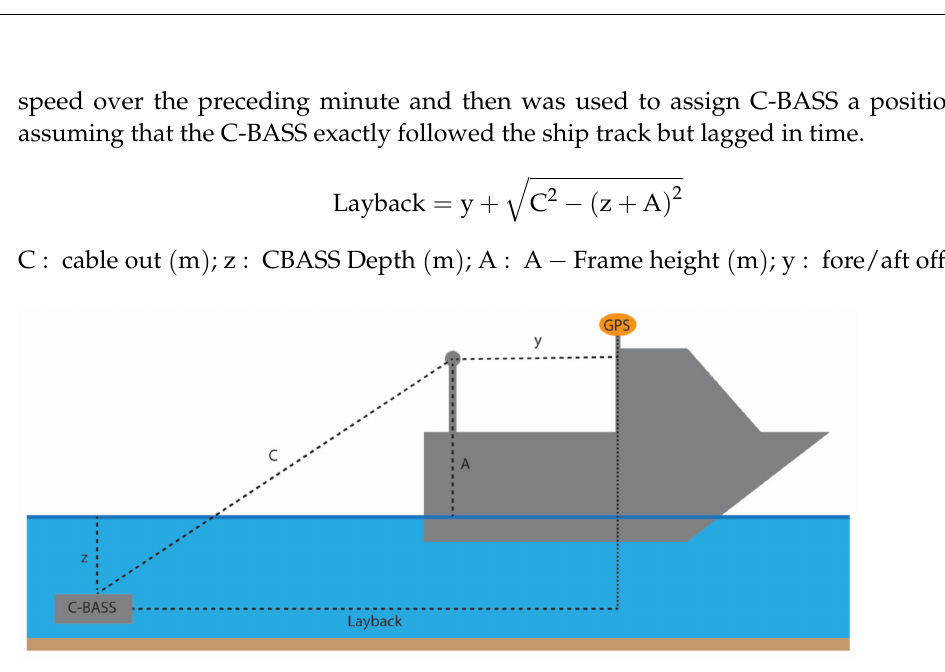
Figure 3. Schematic representation showing the physical meaning of the parameters from Equation (1) that were used to calculate the layback of the Camera-Based Assessment Survey System (C-BASS) system behind the ship’s GPS